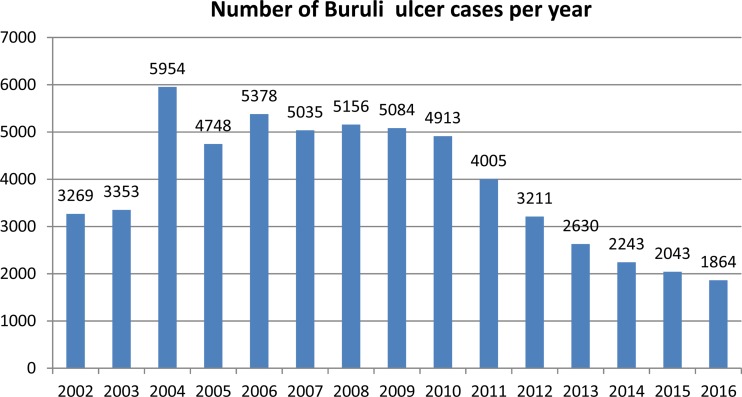
Number of Buruli ulcer cases worldwide reported to the WHO from 2002 to 2016.